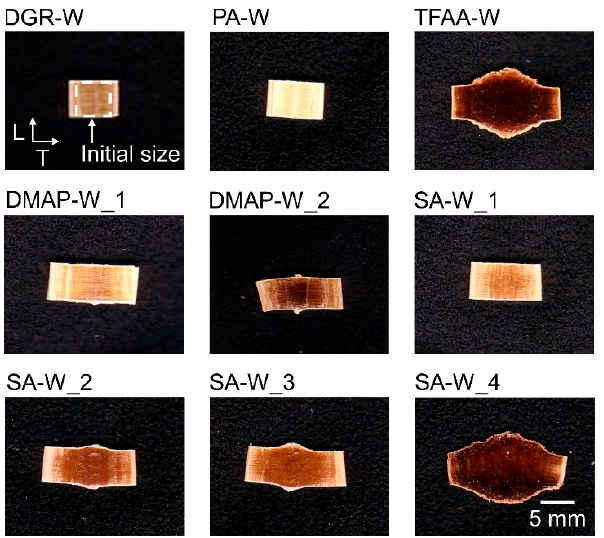
Figure 6. Photographs of degreased and propionylated wood samples after hot compression tests.